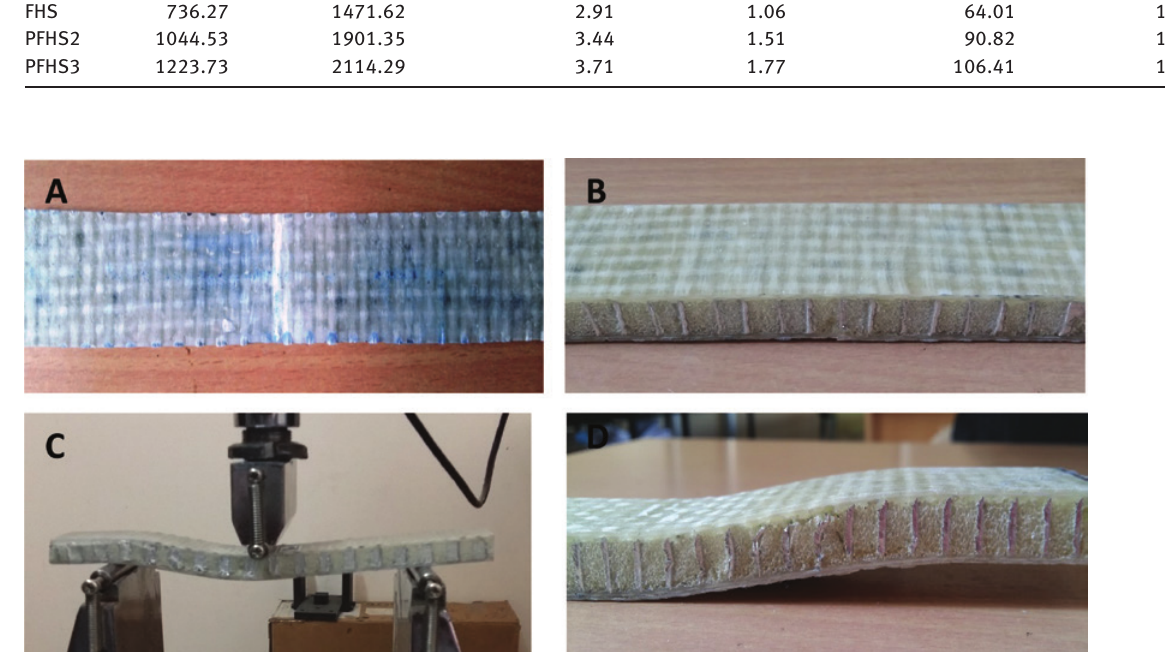
Figure 13: Failure mechanisms of sandwich panels under flexural loading (A, B) FHS panel, and (C, D) PFHS